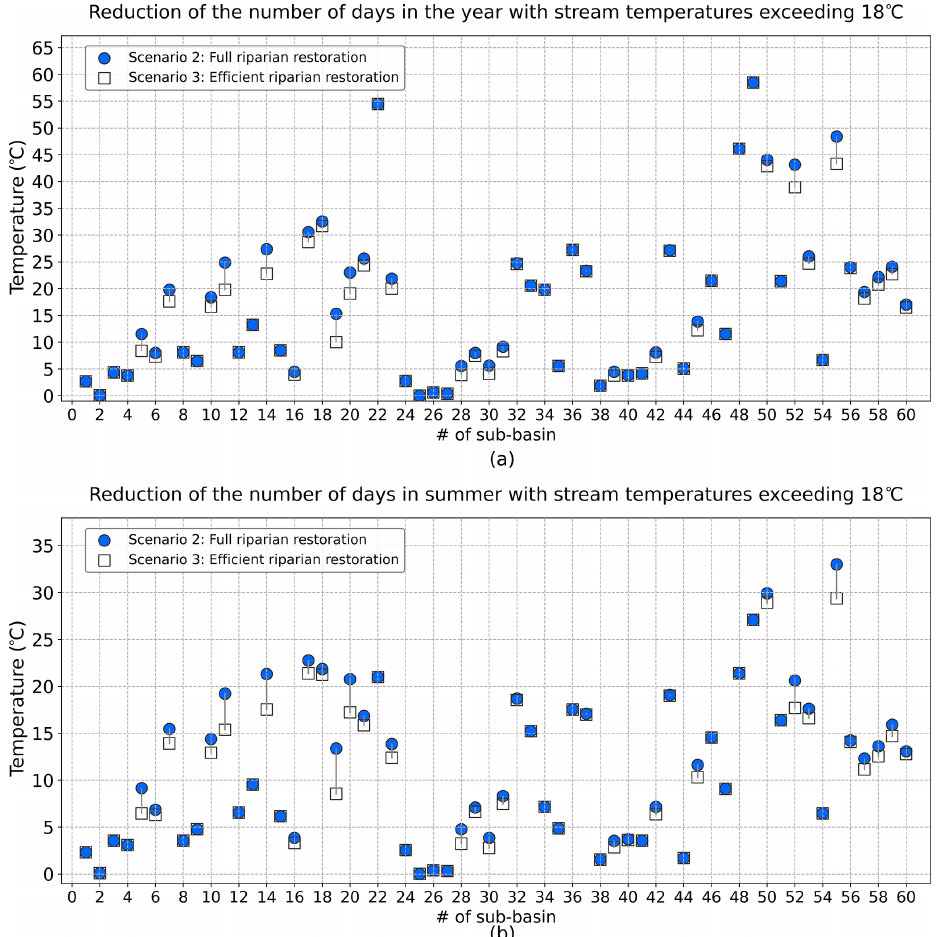
Figure 7. Reduction of number of days in (a) the year and in (b) summer with 7dAM stream temperatures exceeding 18 ◦ C in scenarios 2 and 3.